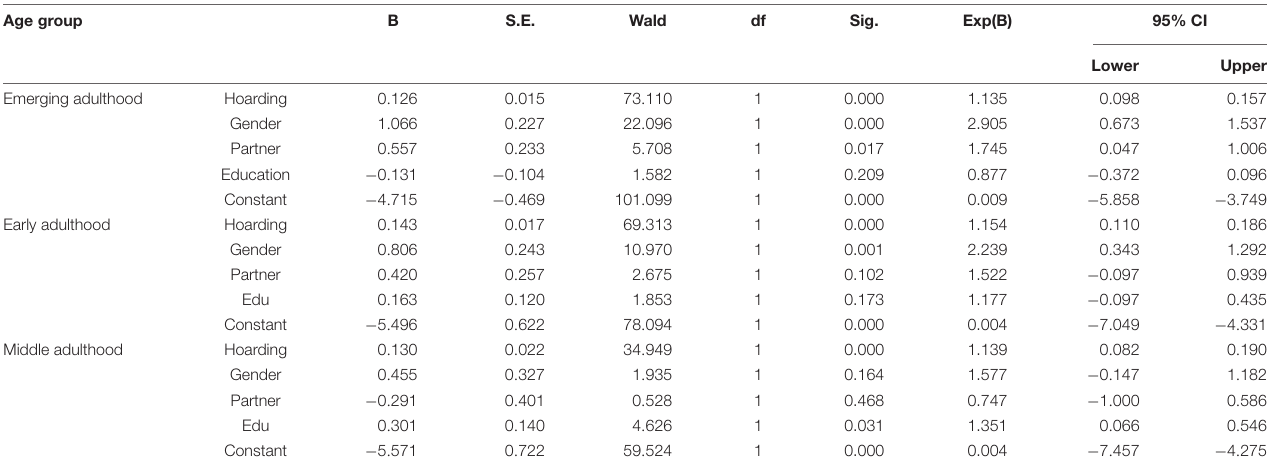
TABLE 2 | Binary logistical regression predicting compulsive